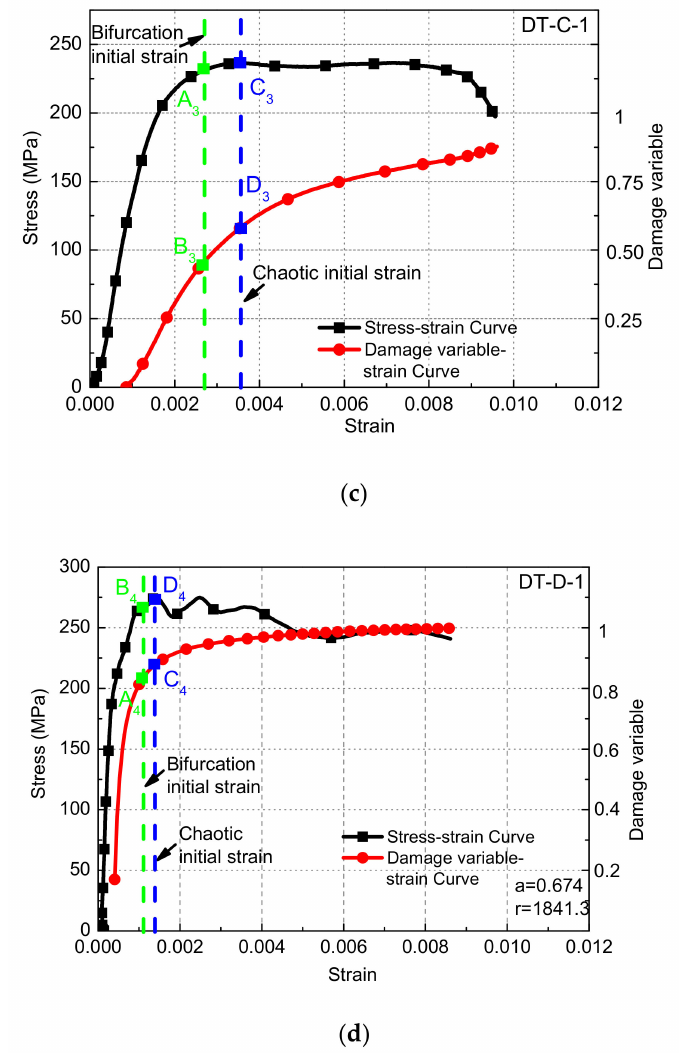
Figure 3. The stress/damage–strain relationship curves of samples at different loading conditions: